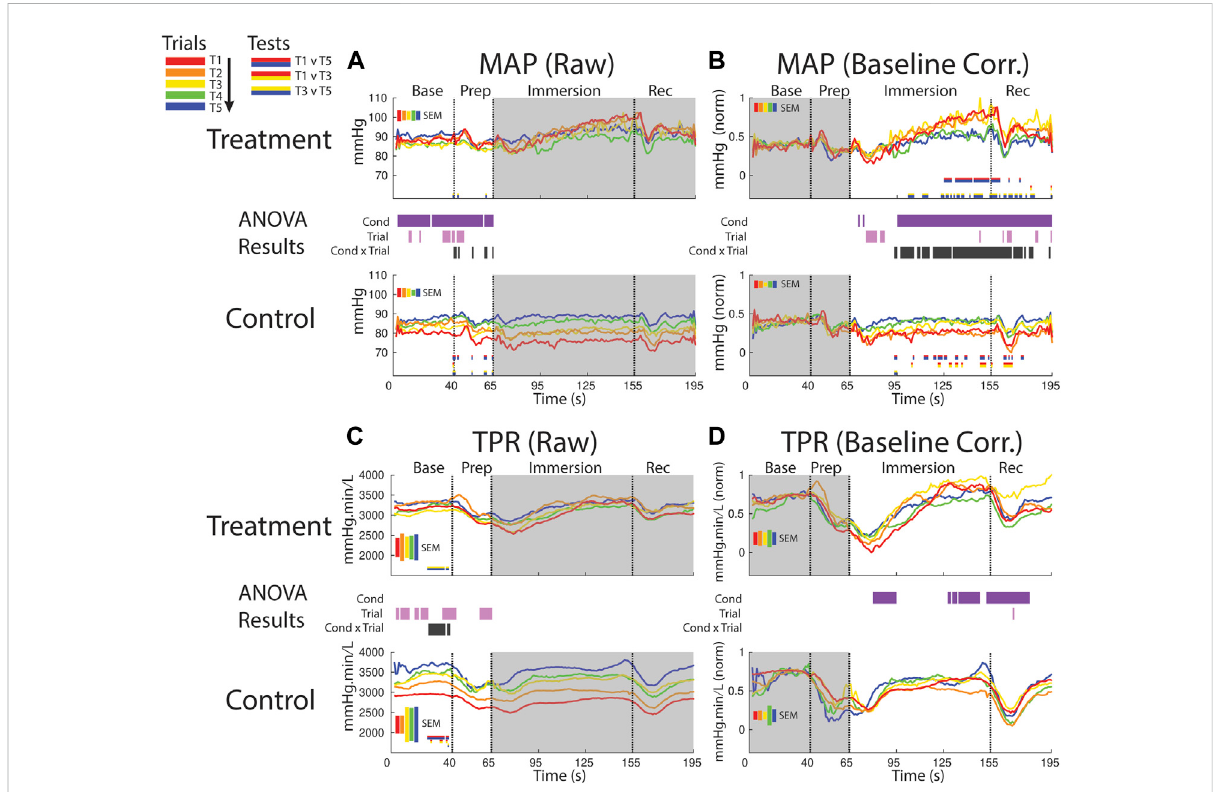
FIGURE 7 Effects of treatment and repeated trial exposure on mean arterial pressure [MAP; (A , B)] and total peripheral resistance [TPR; (C , D)] . Pre- exposure and evoked stress effects are re fl ected in raw (left column) and baseline corrected/normalized (right column) plots, respectively. Each panel contains a separate plot for the treatment and control condition, with the mean response across participants in each repetition trial (T1-T5) represented in each plot by a different color (ROYGB). Horizontal lines positioned between treatment and control plots indicate statistically signi fi cant ANOVA main effects of condition (dark purple), trial (light purple) and the condition x trial interaction (dark gray) at designated timepoints ( p null < 0.05). Horizontal red/blue, red/yellow and yellow/blue lines at the base of treatment and control plots respectively indicate statistically signi fi cant pairwise comparison results for T1 v T5, T1 v T3 and T3 v T5 at the designated timepoints ( p null < 0.05). Post-immersion raw data and